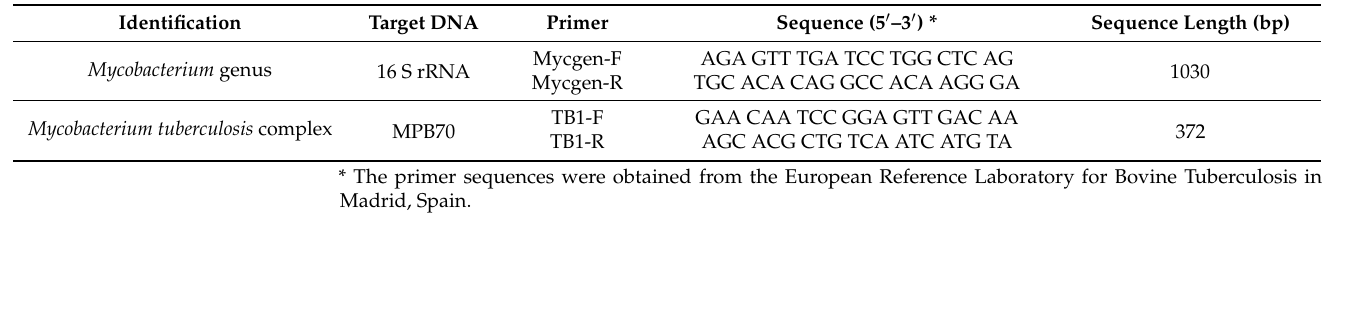
Table 1. Starter sequences used in the